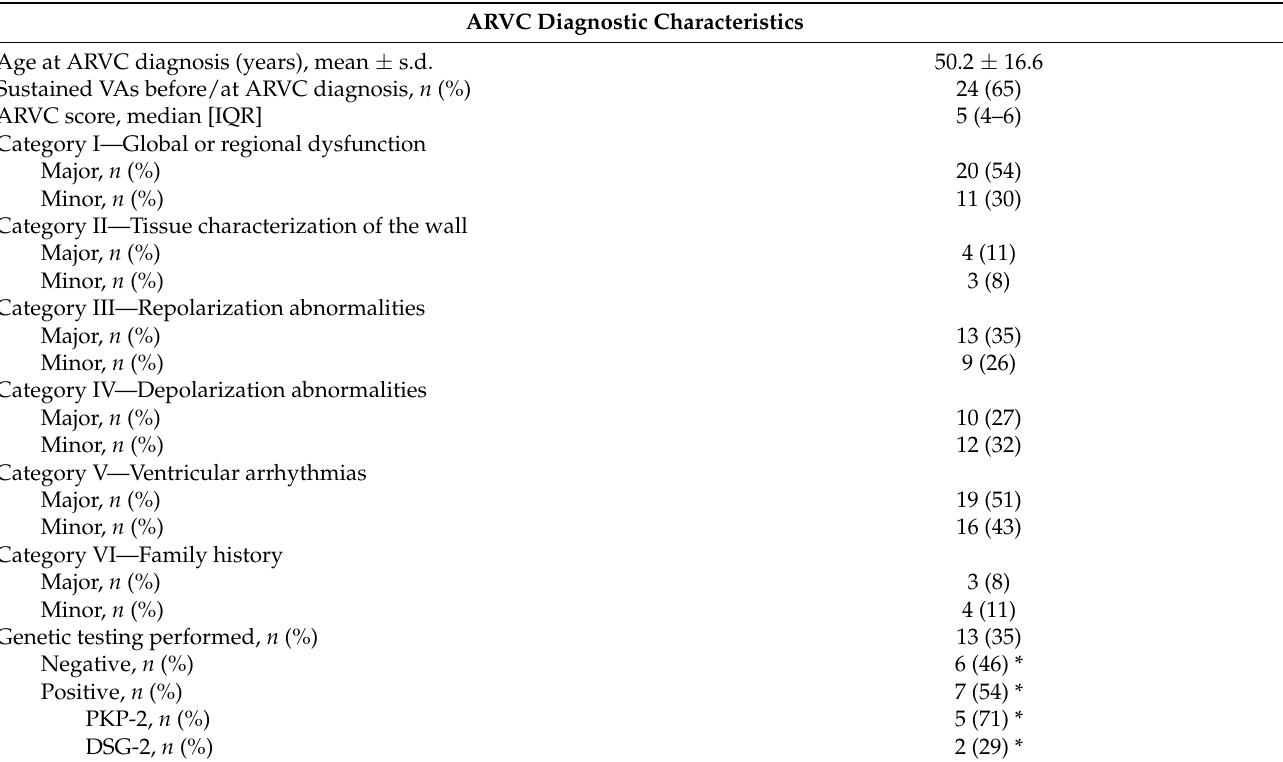
Table 1. ARVC diagnostic characteristics of the study cohort. ARVC Diagnostic